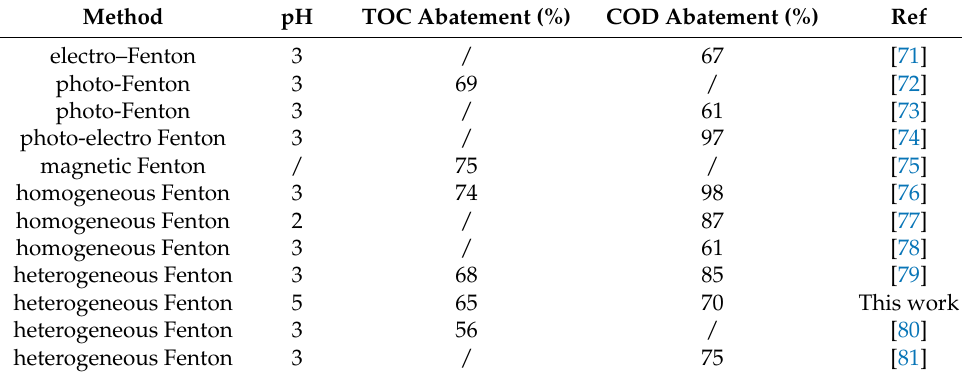
Table 2. Comparison with literature